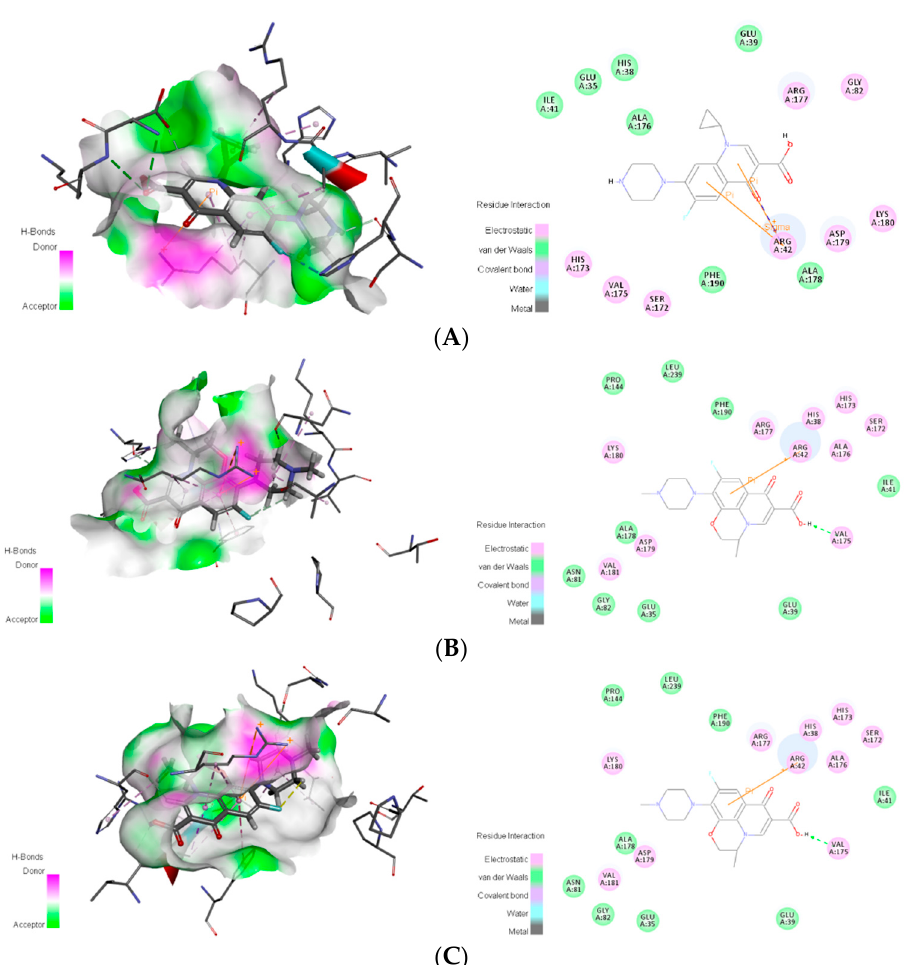
Figure 5. Schematic diagram of the binding for a novel degrading enzyme (3-6) and a target fluoroquinolone molecule. The left is the schematic diagram of the hydrogen donor, and the right is the 2D model diagram: ( A ) ciprofloxacin; ( B ) norfloxacin; ( C ) ofloxacin. Table 7. Interaction between novel degrading enzymes and target fluoroquinolones.